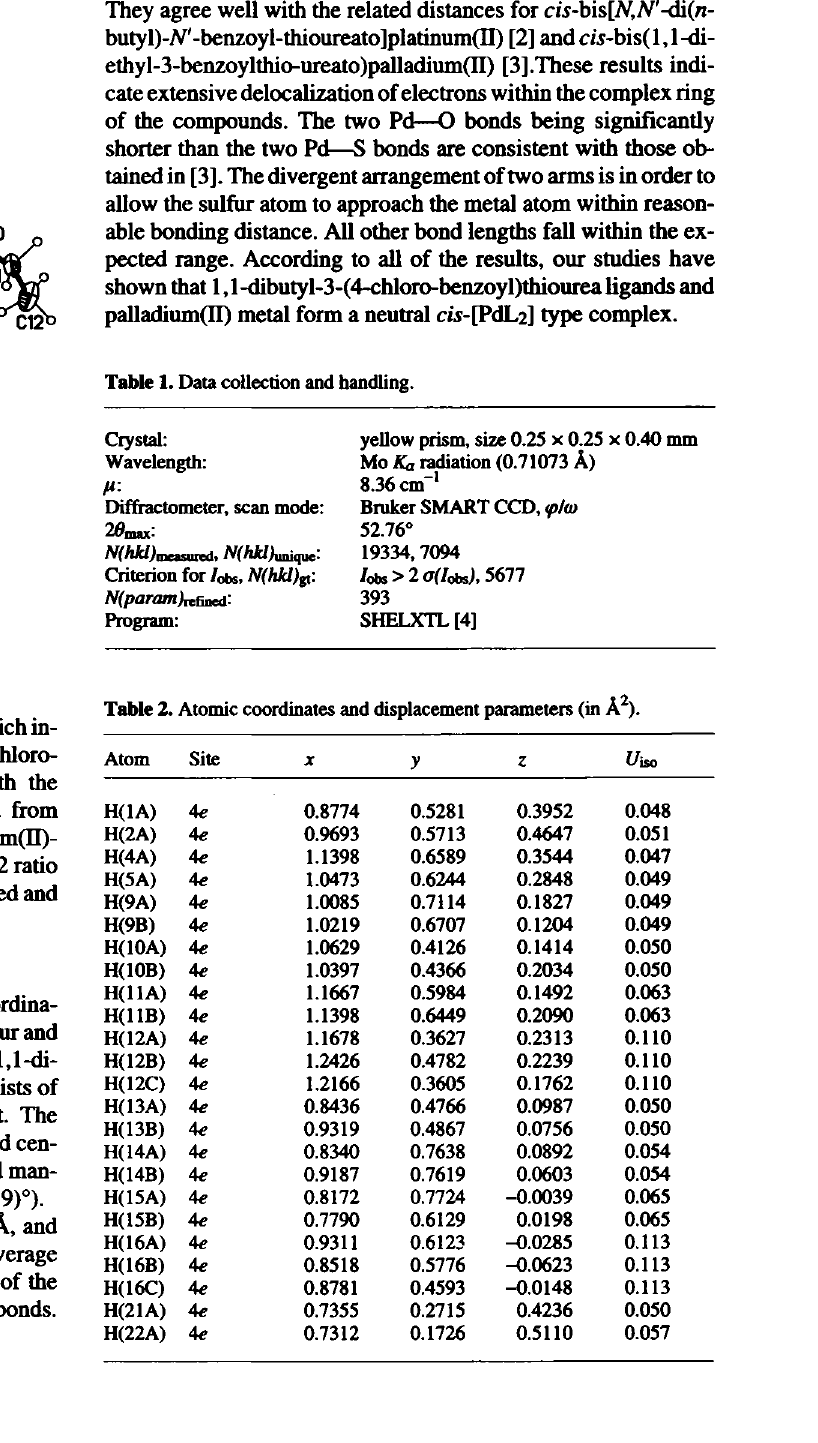
Table 1. Data collection and handling.